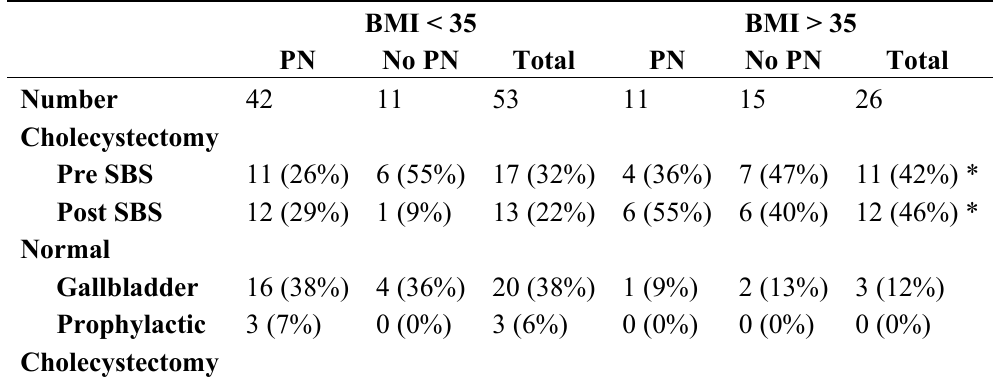
Table 5. Biliary disease in short bowel syndrome (SBS)